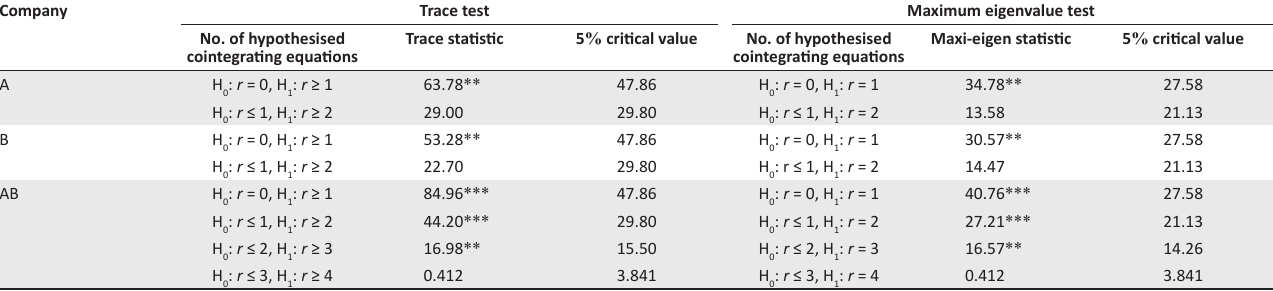
TABLE 3: Johansen trace and maximum eigenvalue statistics for cointegrating vector. Company